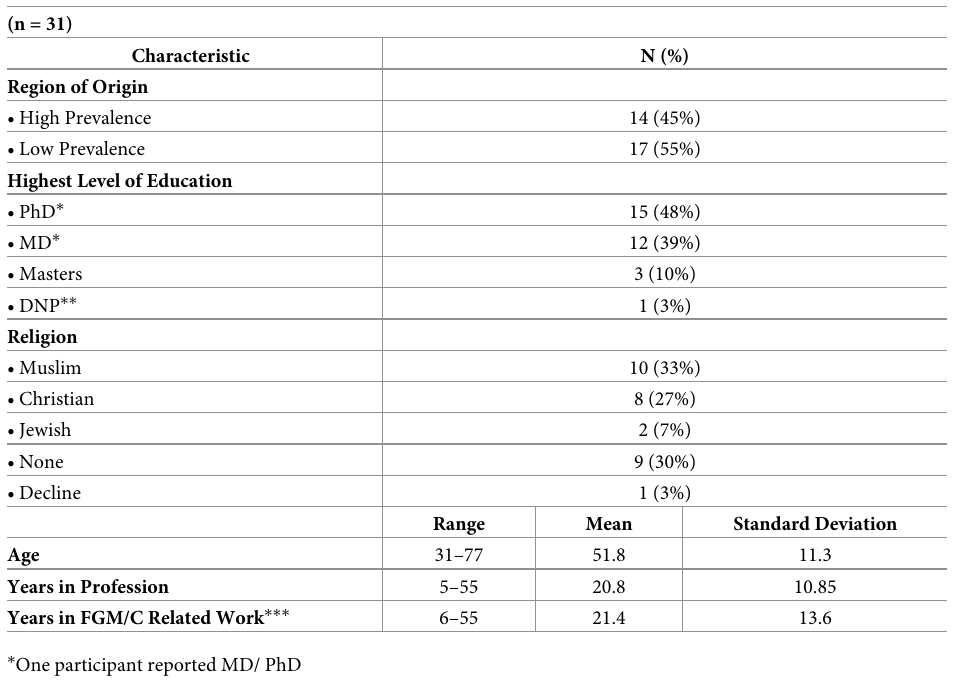
Table 2. Participant